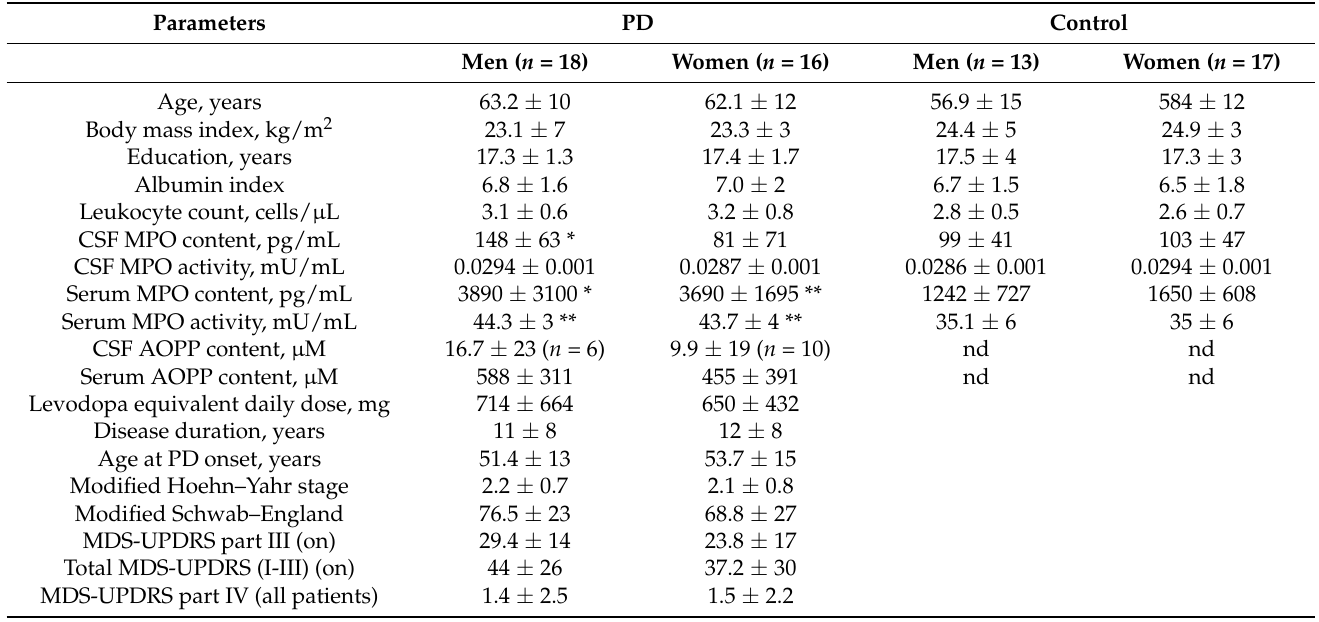
Table 3. Demographic and clinical parameters in the cerebrospinal fluid and serum in men and women.